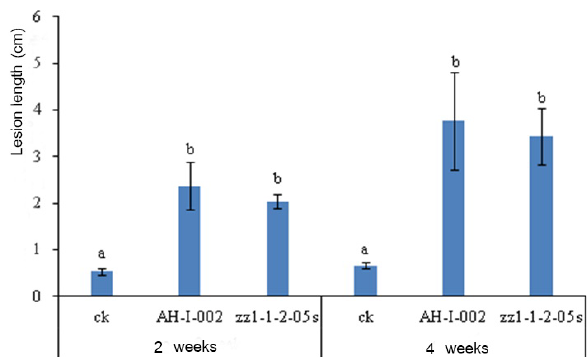
Figure 5. Necrosis length caused by Neofusicoccum man- giferae isolates (AH-I-002 and ZZ1-1-2-05S) inoculated on shoots of standing grapevines (N=3) after 2 and 4 weeks. ck: non-inoculated control. Error bars indicate standard deviation of the mean. Significant differences ( P <0.05) be- tween means are indicated with different letters according to Duncan’s multiple range